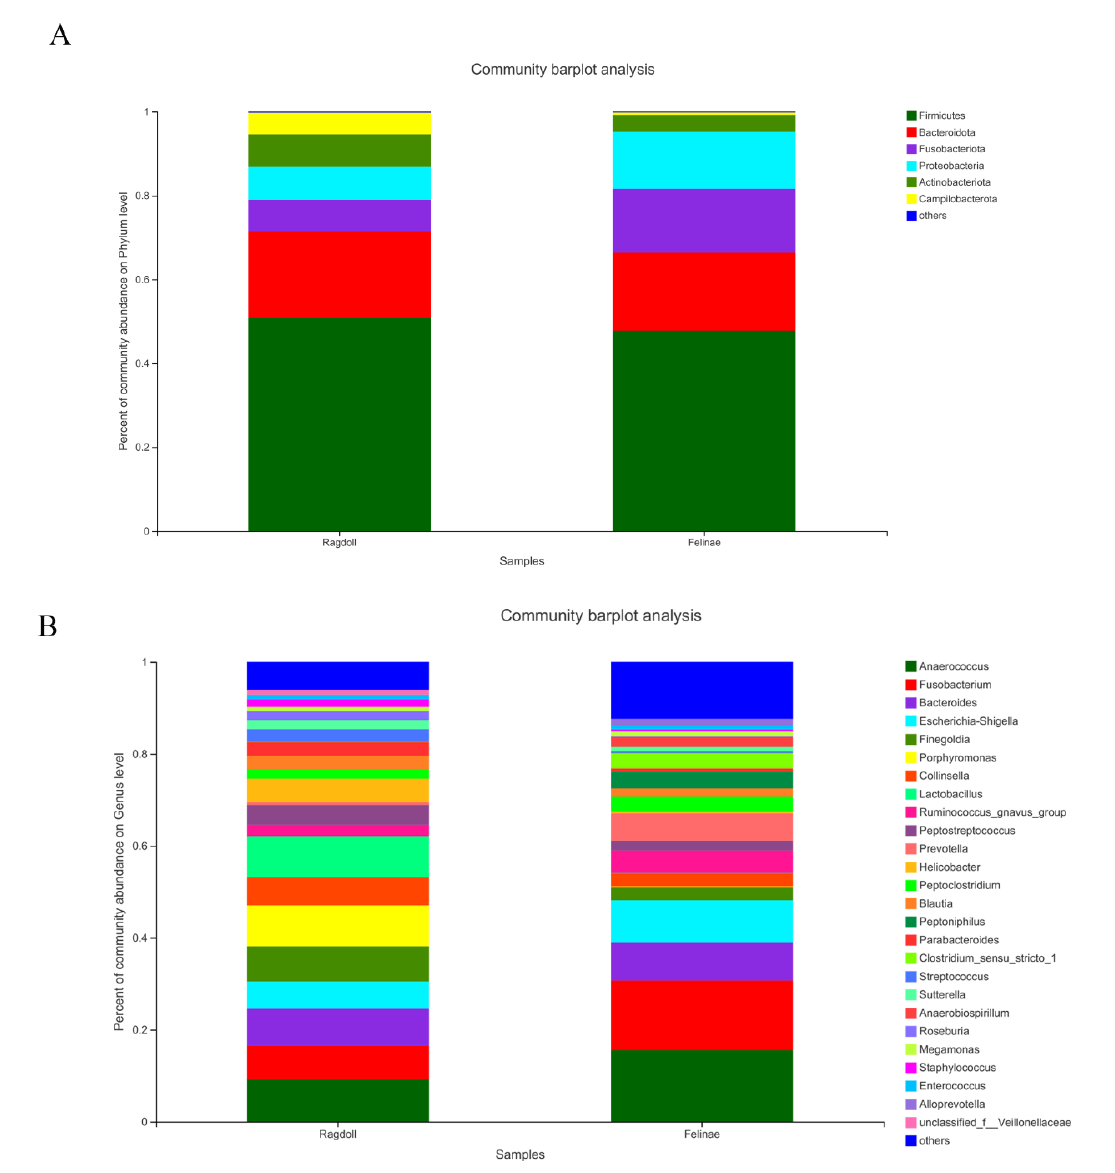
Figure 3. The compositions of the feline gut microbiota at the phylum ( A ) and genus ( B )